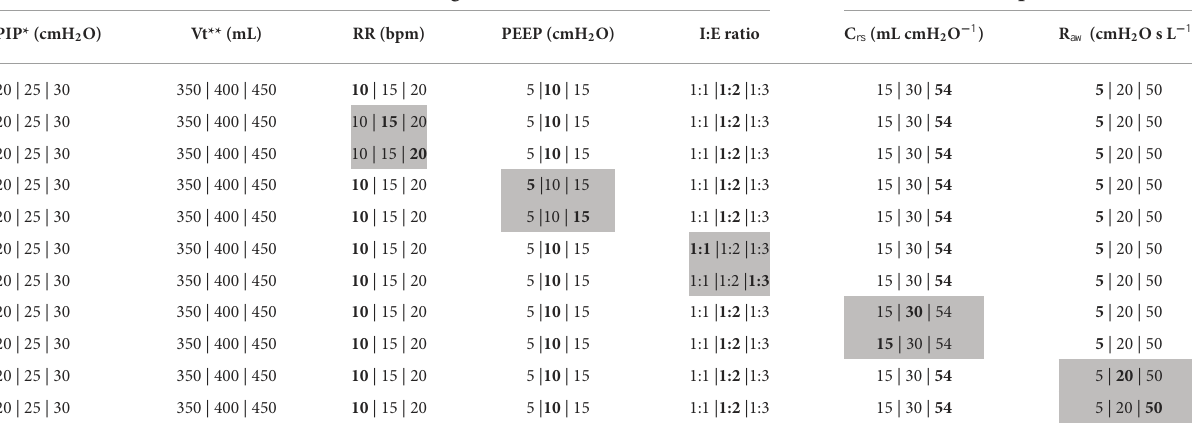
TABLE 2 Ventilator settings for the individual tests performed. Ventilator settings TestChest parameters